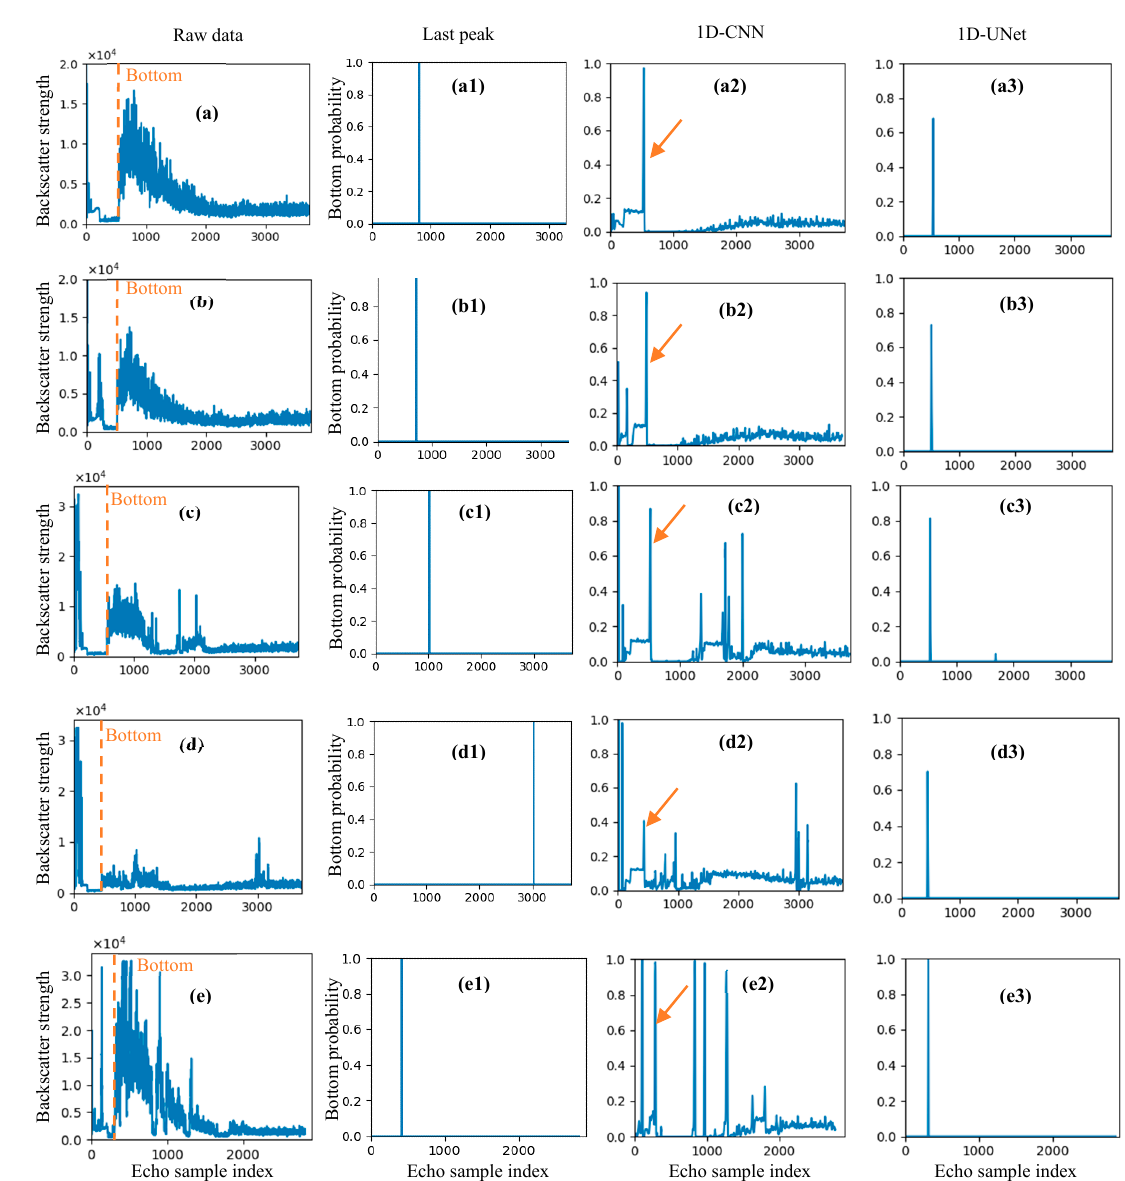
Figure 12. Bottom detection results of five different side-scan ping data processed by the last peak method, 1D-CNN, and 1D-UNet. Panels ( a – e ) show five different backscatter strength sequences, and i 1 to i 3 ( i = a, b, . . . , e) are the detected bottom results using the last peak, 1D-CNN, and 1D-UNet, respectively.